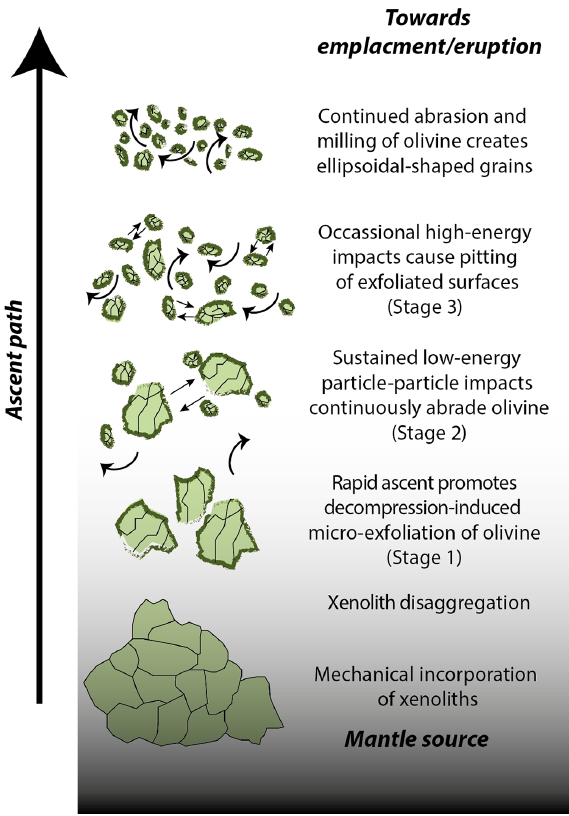
Figure 11. Summary model for the evolution of olivine during as- cent of kimberlite. Kimberlite ascent processes cause brittle defor- mation of mantle peridotite, leading to production and entrainment of mantle xenoliths. Peridotitic xenoliths undergo mechanical dis- aggregation due to particle–particle collisions and decompression. The decompression is driven by rapid ascent and promotes tensile failure in liberated olivine crystals and is expressed as surface par- allel micro-exfoliation. High-velocity (i.e. turbulent) transport of olivine in a solids-rich melt–gas mixture of kimberlite magma sup- ports continual high-frequency low-energy impacts between parti- cles, leading to abrasion and rounding of olivine grains. Periodic higher-energy impacts create impact pits on the olivine’s exfoliated microsurfaces. The combination of these processes results in a high proportion of ellipsoidal-shaped, abraded and decompressed olivine grains within the IH